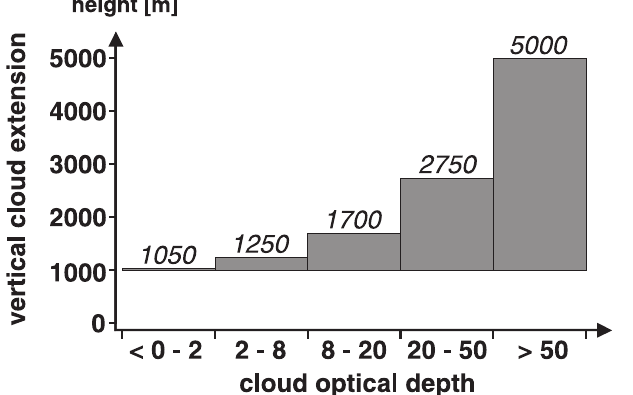
Fig. 4. Correlation between optical and geometrical cloud depth. In the case of satellite observations the cloud base is assumed to be uniformly 1 km above ground, whereas the top heights (given by the italic numbers ) depends on the optical depth class to which the cloud belongs. The vertical cloud extensions are chosen to ensure a cloud extinction coe(cid:129)cient of 20 km (cid:255) 1 (at 550 nm) for the mean of each optical depth class